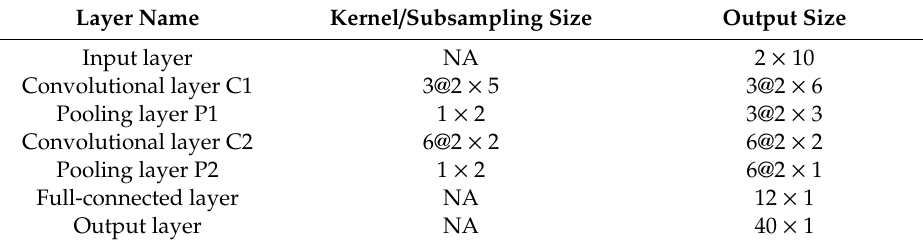
Table 1. The configuration information of convolutional neural network